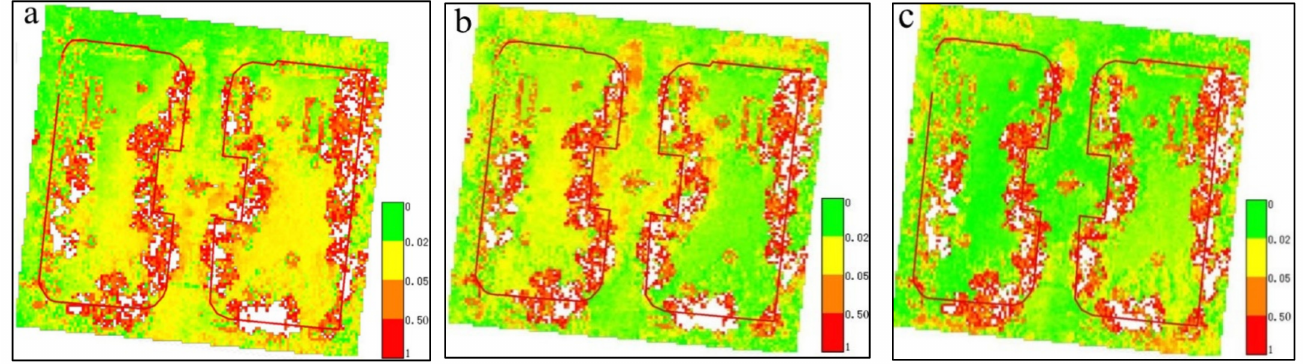
Figure 5. Change detection model diagram of DOD-DSM: ( a ) DOD-DSM1; ( b ) DOD-DSM2; ( c )